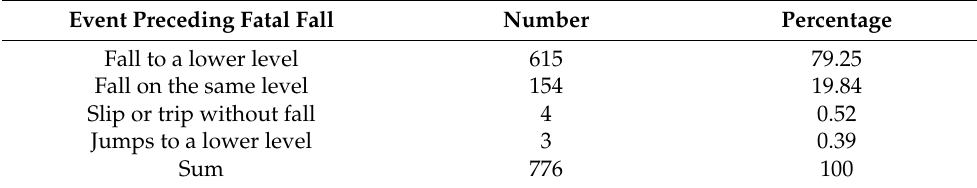
Table 2. US occupational fatalities by event preceding fatal falls in 2018